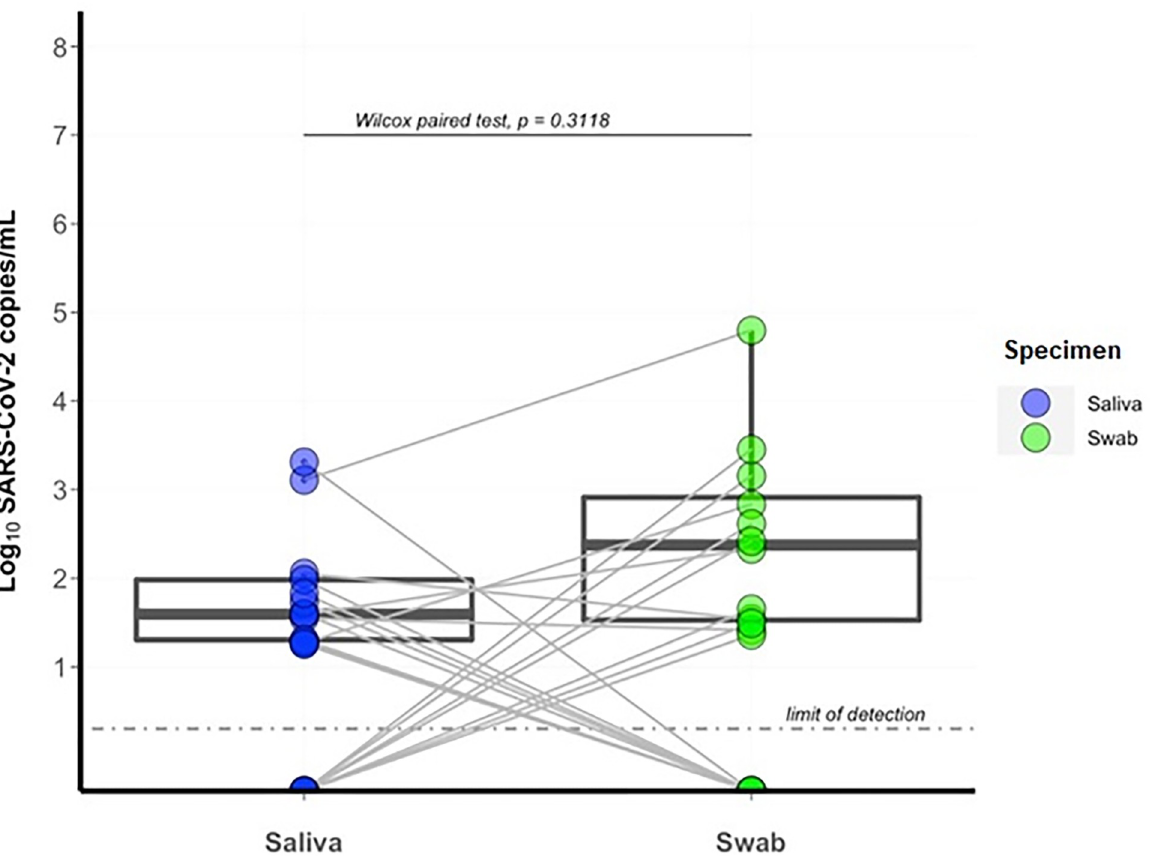
Fig 4. Comparison of SARS-CoV-2 viral load in paired oropharyngeal/nasopharyngeal swab and saliva samples. The logged viral load of paired saliva and nasopharyngeal (NP) samples (n = 20) from healthcare workers for the first 8 weeks of the study period is shown. Paired samples were those where the participant self-collected both saliva and OP/NP sample on the same date. Data points for a single sample are represented by a point outlined by a circle and a single line connects paired samples. Boxes represent interquartile range (IQR) with a median central line.